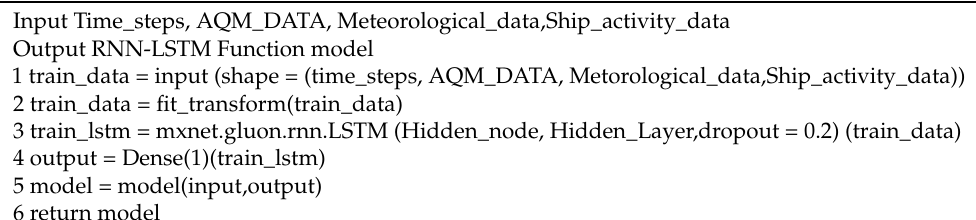
Table 3. Algorithm of RNN-LSTM designed for data training and prediction.